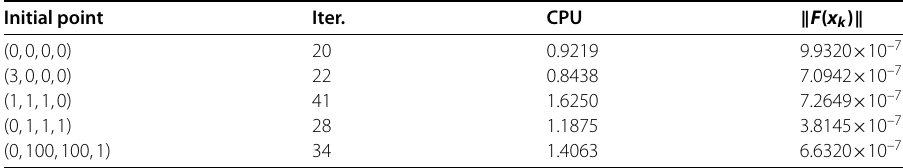
Table 1 Numerical results with different dimensions of Problem 1 Dimension 10 50 100 500 1,000 Iter. 20 21 22 23 23 CPU 0.3594 0.8750 1.7031 41.4844 257.1406 Table 2 Numerical results with different initial points of Problem 3 Initial point Iter.